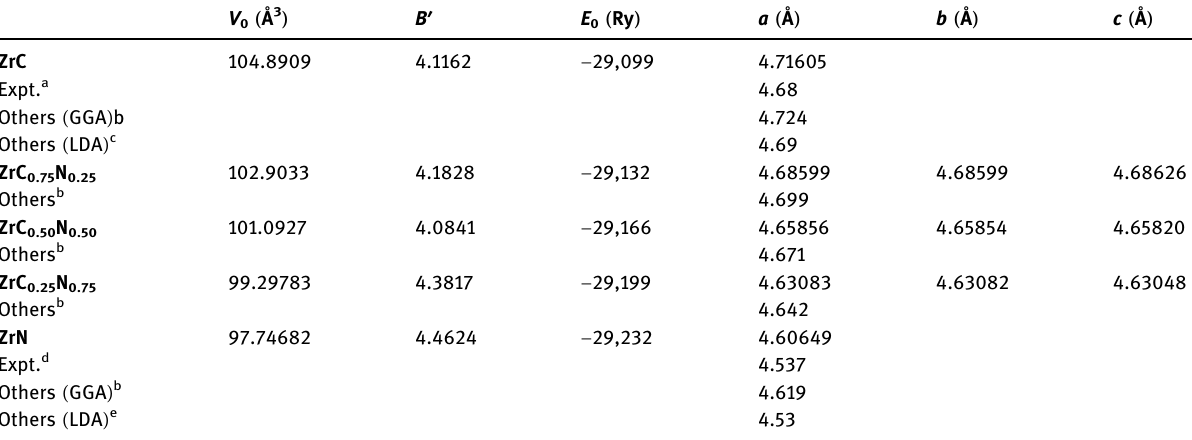
Table 1: Volume ( V 0 ) , energy ( E 0 ) , and lattice constant of the ground state structure ( a ) , the fi rst pressure derivative of the bulk modulus ( B ) calculated from the Birch – Murnaghan equation and the experimental and other calculated theoretical values